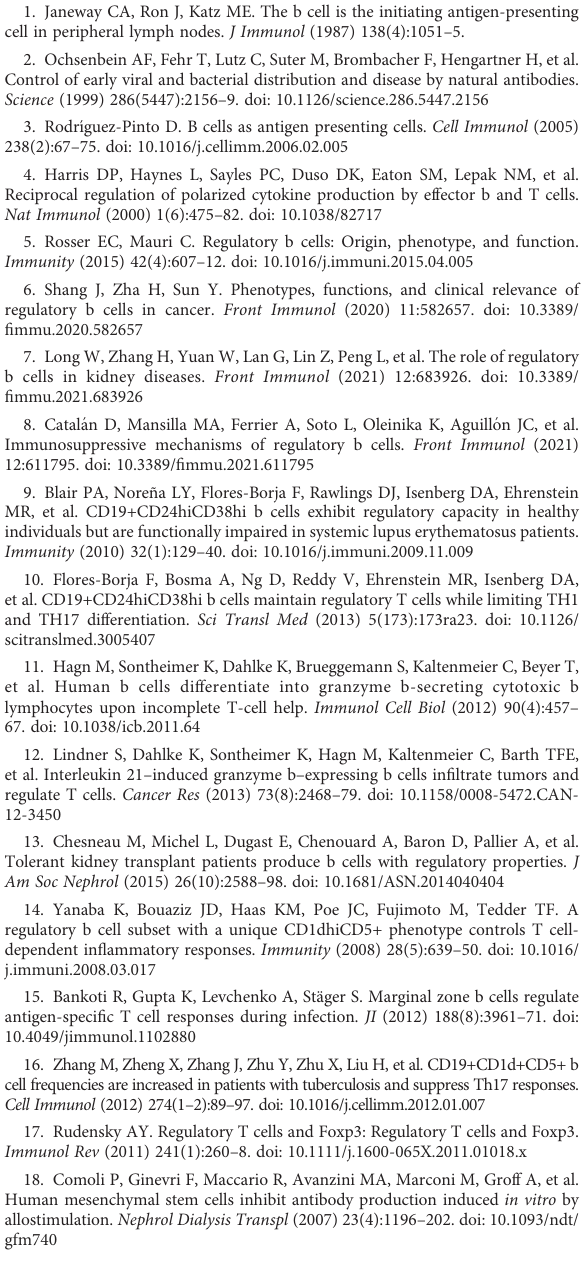
SUPPLEMENTARY FIGURE 4 Analysis of published Breg markers distribution between IL-10+ and IL- 10- groups comparing normalize gene expression. Graphs include gene Name and p-value from the statistical analysis. Error bars represent SD. Non-parametric T-test was performed to determine statistical signi fi